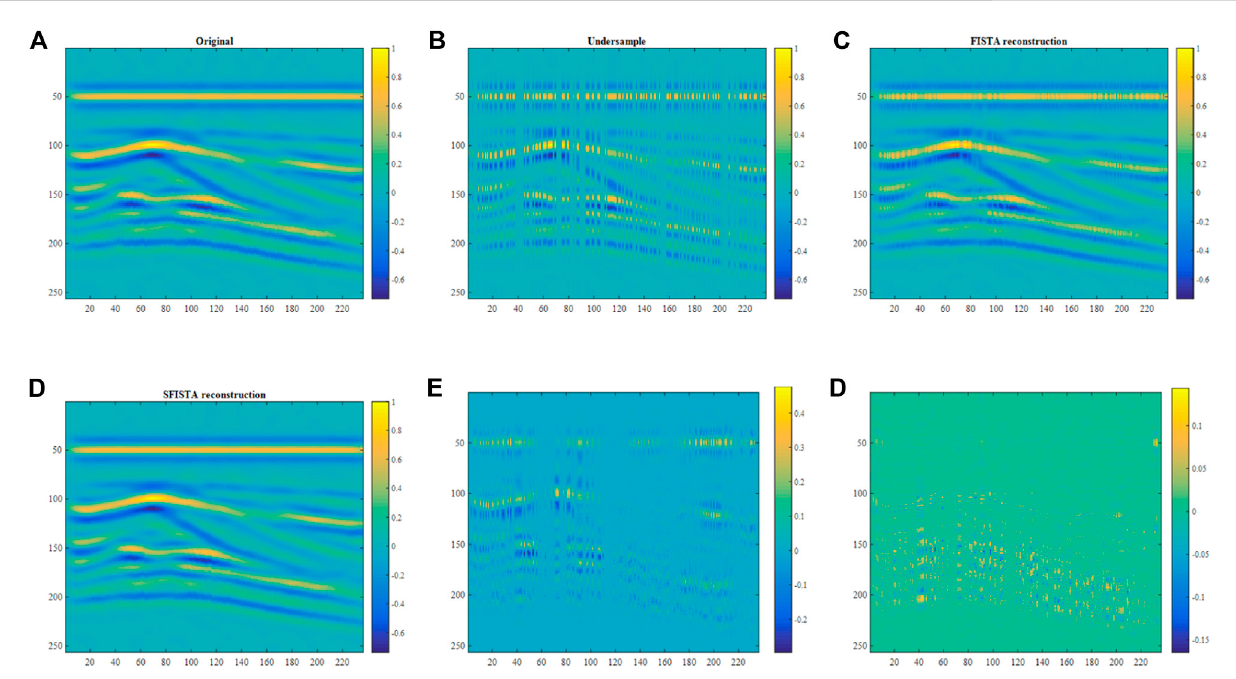
FIGURE 4 Reconstruction results of the coral reef model in the curvelet domain. (A) Original data; (B) 50% of randomly missing data; (C) interpolated data obtained by the FISTA method; (D) interpolated data obtained by the SFISTA method; (E) reconstructed errors obtained by the FISTA method; (F) reconstructed errors obtained by the SFISTA method.